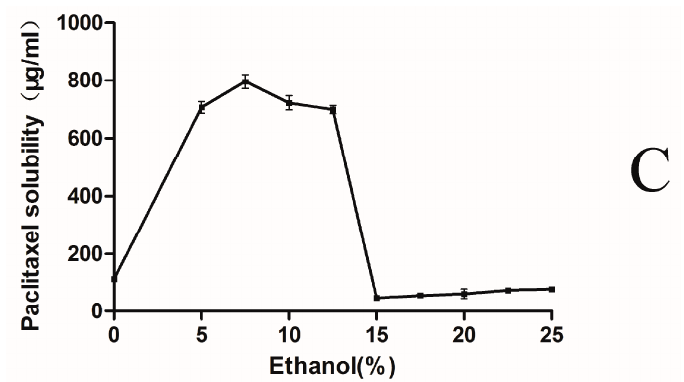
Figure 2. Phase-solubility diagram of PTX-GA systems at 25 °C in water ( A ), in different ethanol/water percentages solution(including 5%, 7.5%, 10% and 25% ethanol) ( B ), in